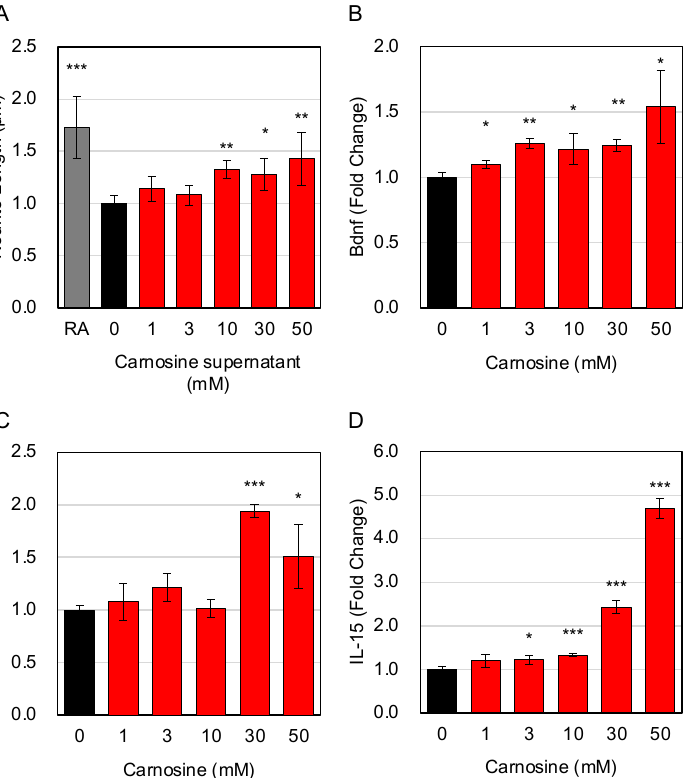
Figure 5. Effects of carnosine on the interaction between muscle cells and neuronal cells. C2C12 cells were differentiated in the presence of the indicated amount of carnosine. Culture supernatants of carnosine-treated C2C12 cells were added to SH-SY5Y cells, and neurite outgrowth in SH-SY5Y cells was evaluated using IN Cell Analyzer 2200. As a positive control, SH-SY5Y cells were cultured with 10 µM of retinoic acid (RA) for 1 day ( A ). The effect of carnosine on the expression of myokine (Bdnf ( B ); Irisin ( C ); IL-15 ( D )) was quantitatively determined by RT-qPCR. Multiple comparisons between groups were performed using one-way ANOVA with Tukey’s post-hoc test. Statistical significance was defined as p < 0.05 when compared to control (* p < 0.05; ** p < 0.01; *** p < 0.001).